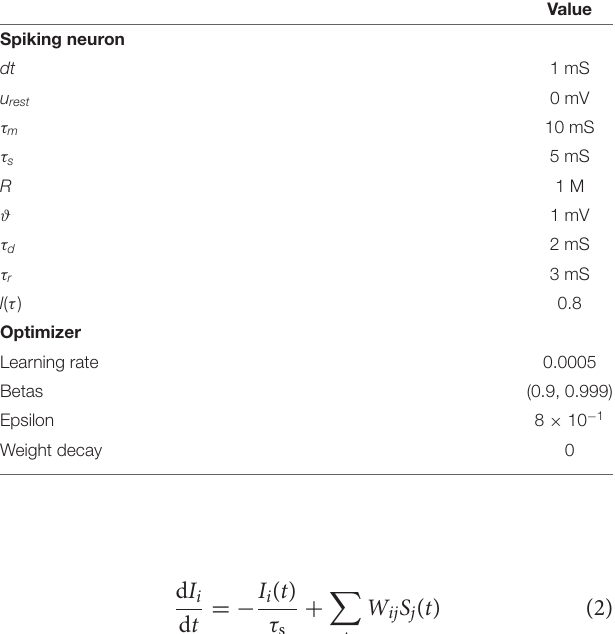
TABLE 1 | List of spiking neuron and Adam optimizer properties.